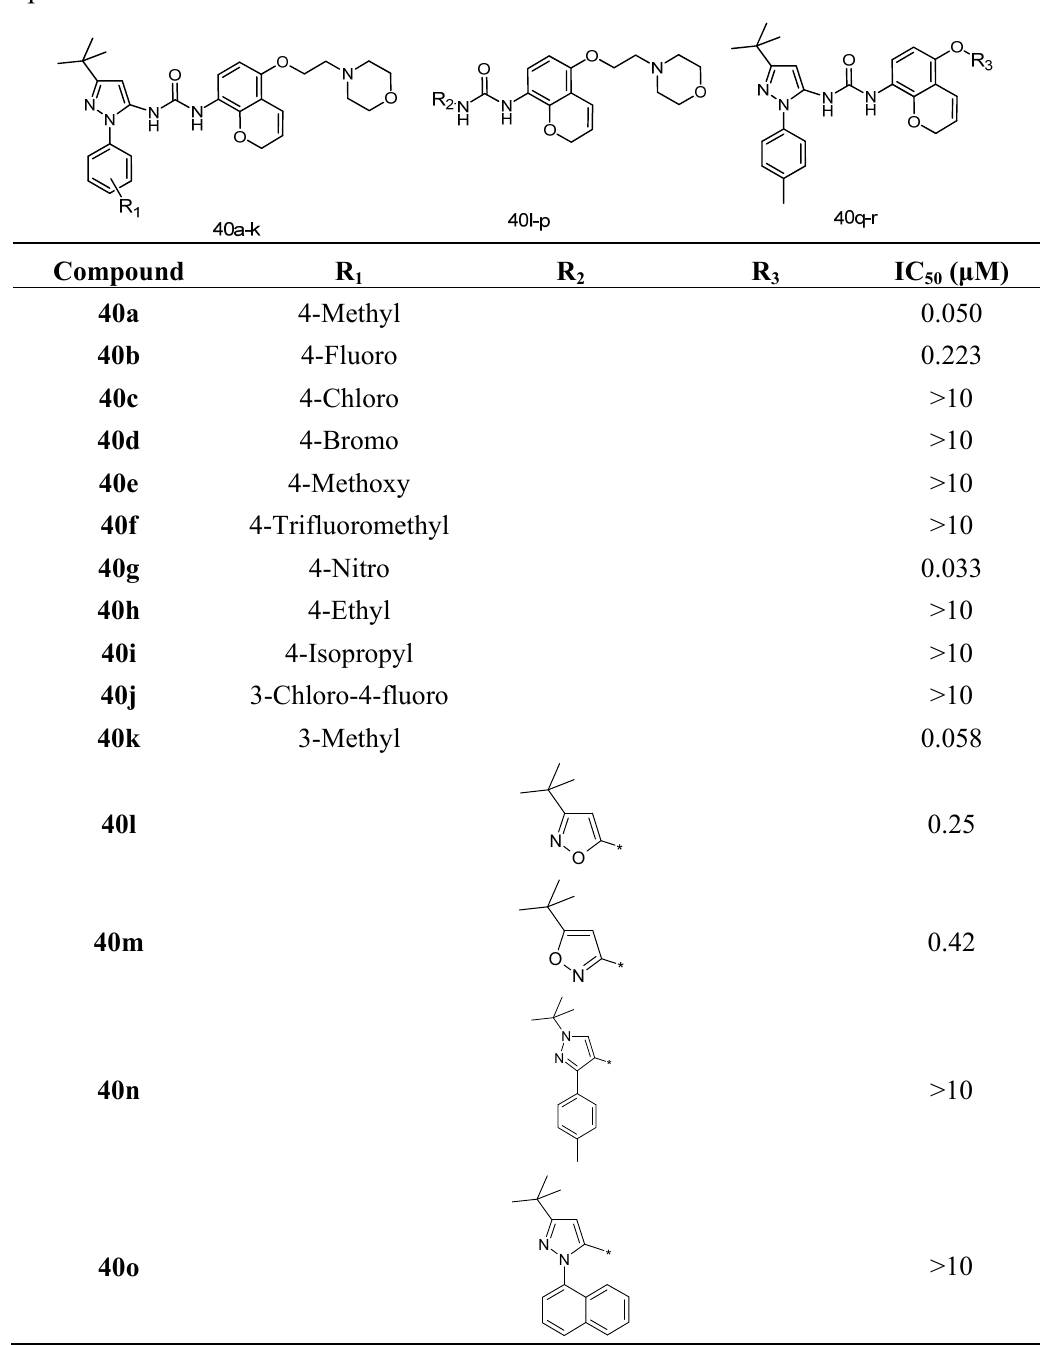
Table 3. Structure and TNF- α inhibitory activity of 1-aryl-3-(2 H -chromen-5-yl) urea compounds 39a – r